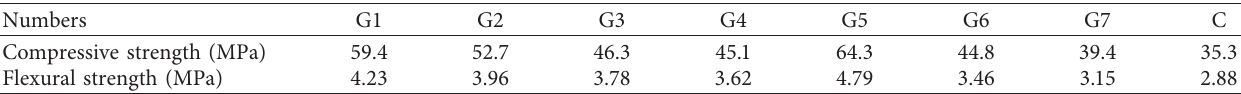
Table 6: Compressive strength and flexural strength of each specimen cured for 7 days at room temperature.